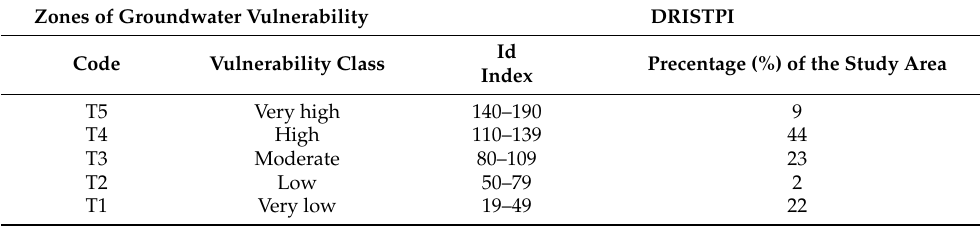
Table 2. Zones and classes of groundwater vulnerability defined by DRISTPI